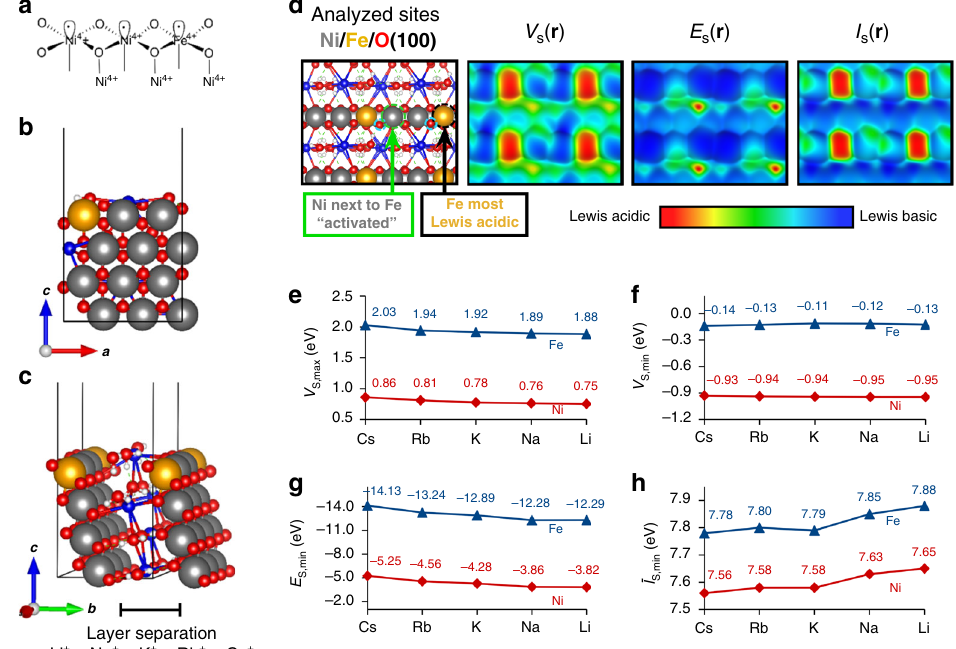
Fig. 5 Computational analysis of the reactive site. a – c Surface model of γ -Ni(Fe)OOH(100) with intercalating water and alkali metal cations. d Top-view of the surface with reactivity properties estimated using DFT mapped on the 0.001 au isodensity contour is shown in. e – h Local extrema in the properties of the most activated Ni/O and Fe/O sites, which indicate the Lewis acidity of Ni and Fe sites ( V S,max and E S,min ) and Lewis basicity of O sites ( V S,min and Ī S,min ). Color code of atomic models: Ni = gray, Fe = orange, O = red, Alkali = blue, H =